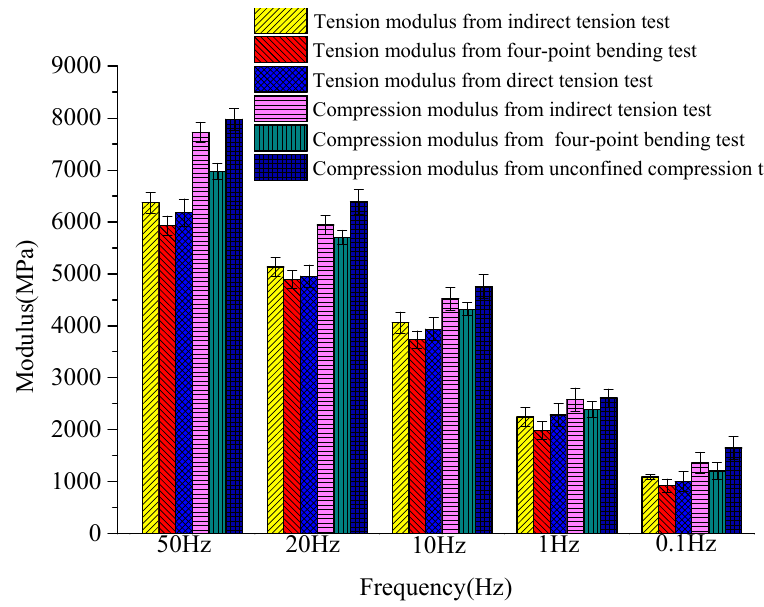
Figure 5. Comparison of six kinds of dynamic loading state.